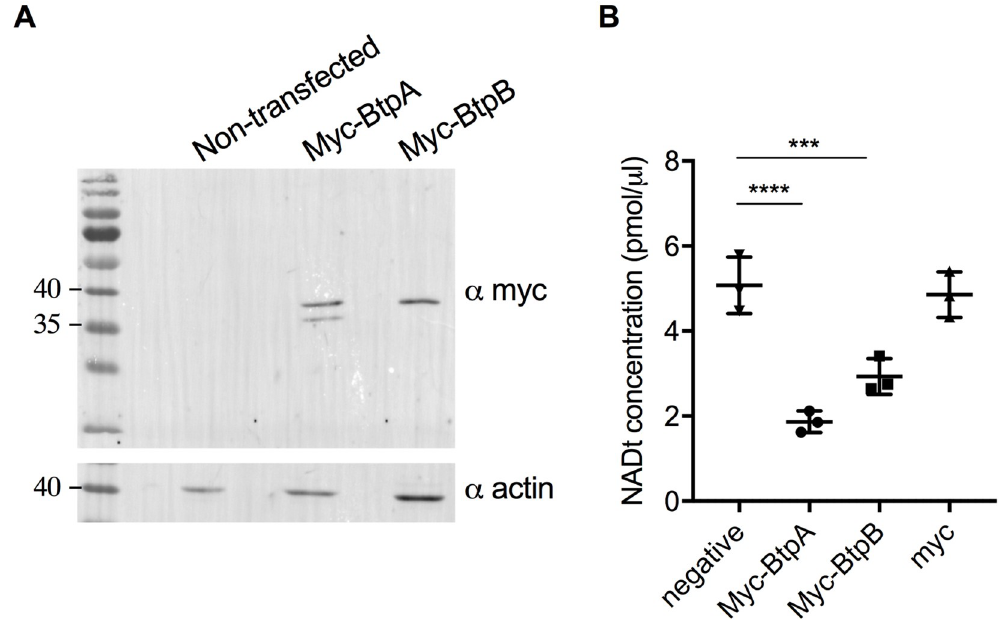
Fig 8. Ectopic expression of BtpB results in reduction of total NAD + in HeLa cells. (A) Representative Western blot showing levels of Myc-BtpA and Myc-BtpB expression revealed with an anti-Myc antibody and anti-actin antibodies, as a loading control. Myc-BtpA has a predicted molecular weight of 33 kDa whereas BtpB 38 kDa. (B) Measurement of total NAD levels using a colorimetric assay from HeLa cells expressing either Myc-tagged BtpA or BtpB. Non-transfected cells (negative) and cells transfected with Myc vector alone are also included as controls. Data correspond to means ± standard deviation from three independent experiments and statistical comparison was done with one-way ANOVA, with a p-value for the negative control versus Myc-BtpA of < 0.0001 ( ���� ) and versus Myc-BtpB of 0.0006 ( ��� ).